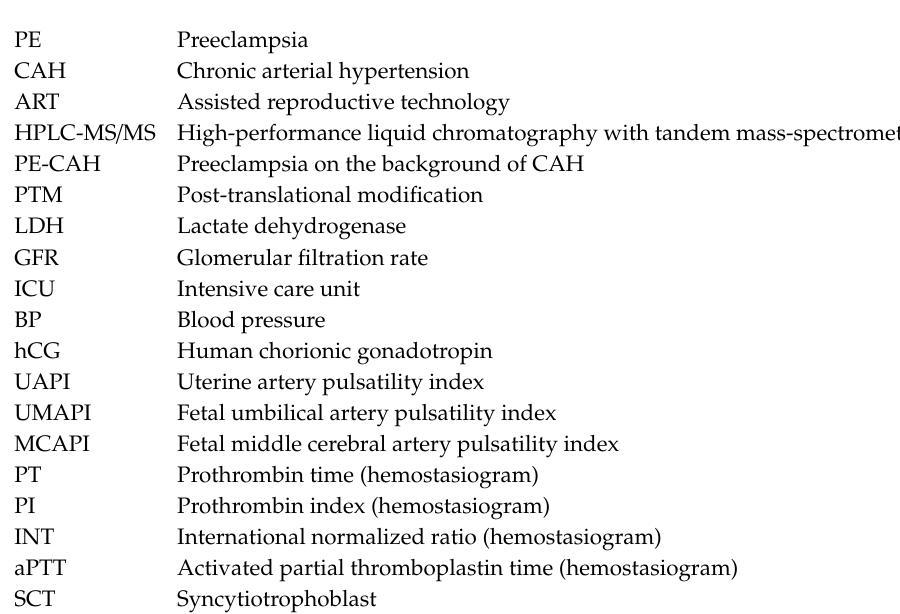
Table S1. Normalized intensity of 248 urinary peptides detected in more than five